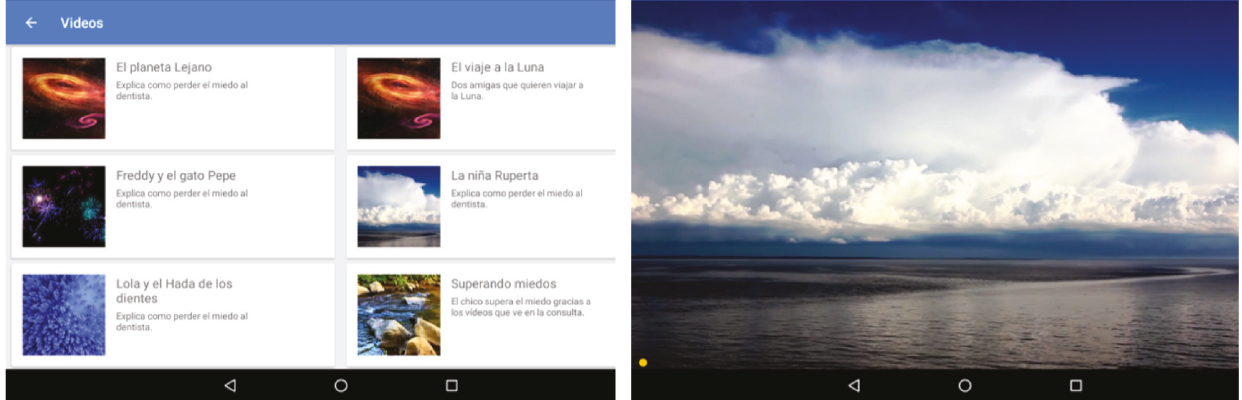
Figure 28: Video menu and